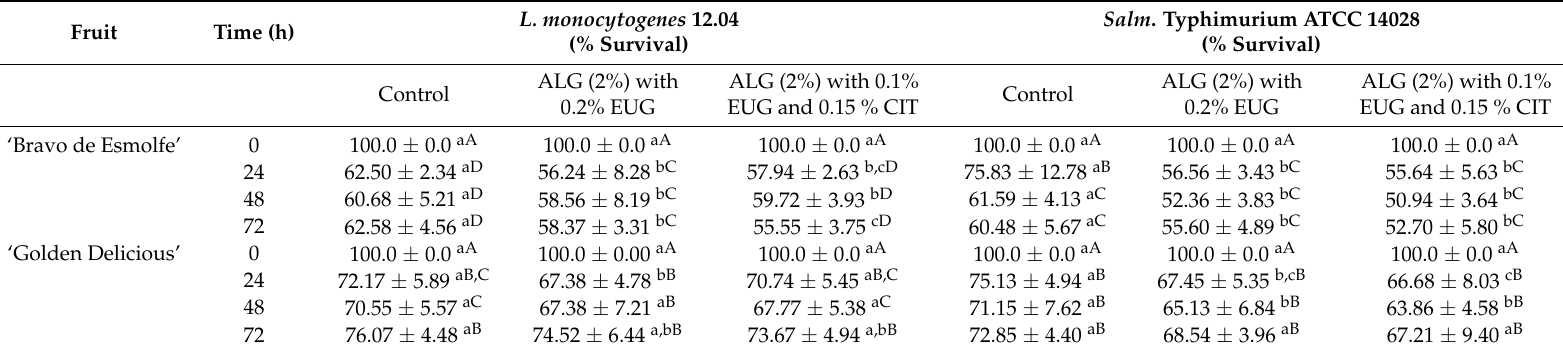
Table 3. The impact of edible coatings on the survival (%) of L. monocytogenes 12.04 and Salm . Typhimurium ATCC 14028 on fresh-cut apples stored at 4 ◦ C.